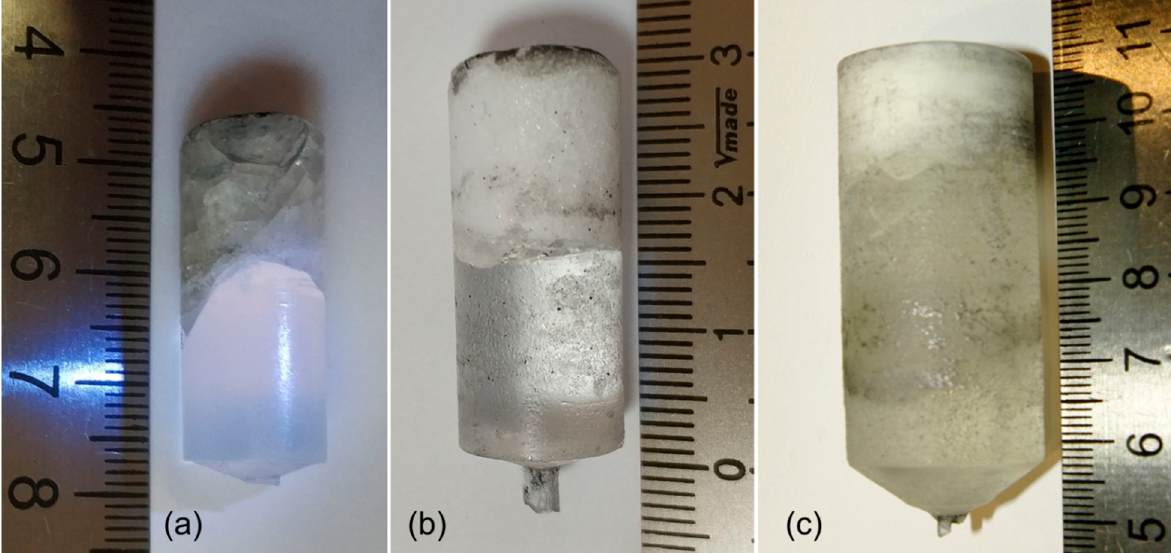
Figure 3. Appearance of as-grown KY 3 F 10 (KYF) crystals with traces of oxygen, obtained using a commercial reagent KF ( a ); transparent KYF ( b ) and KTb 3 F 10 (KTF) ( c ) crystals grown using potassium hydrofluoride as an initial reagent.